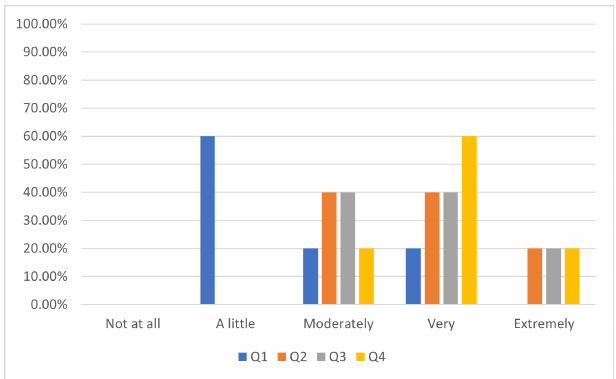
Figure 5. Overall percentage selection for questions Q1 to Q4 in Table